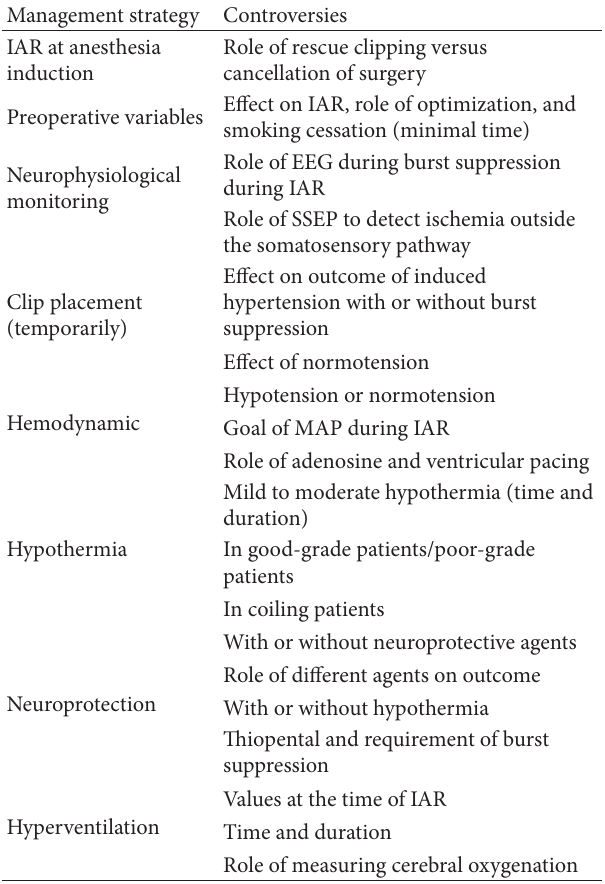
Table 3: Controversies in the management of